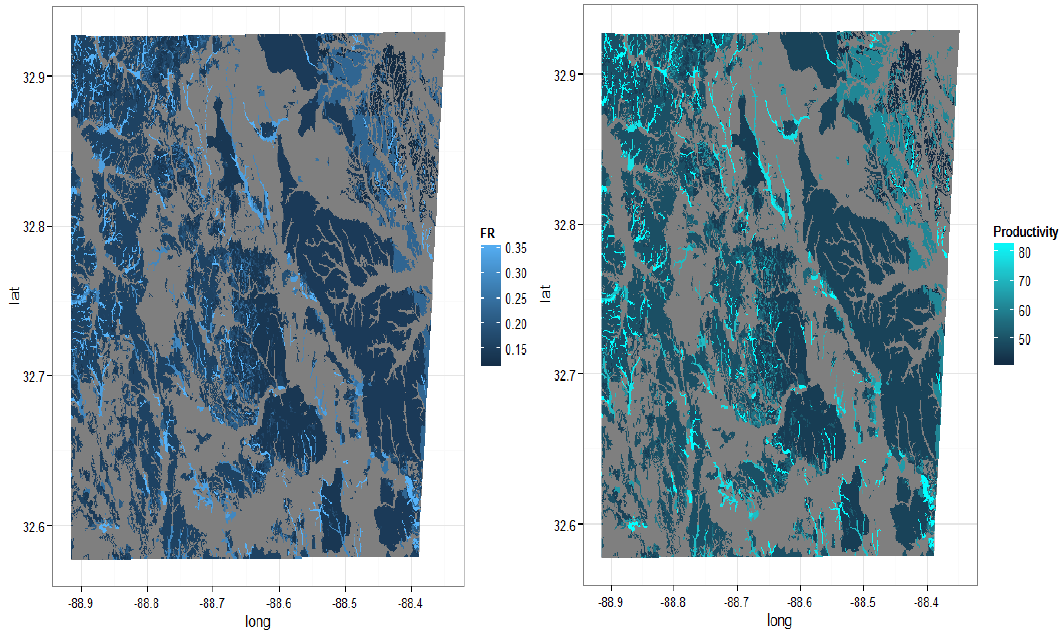
Figure 9. Map of 3-PG predicted aboveground biomass (Mg ha − 1 ) for 12-year-old loblolly pine in Kemper County, Mississippi. The top left diagram shows soil series mapped in Kemper County Mississippi based on SSURGO database. The top right diagram shows site index at base 25 calculated from SSURGO site index at base age 50 using the base age invariant method developed by [41]. The bottom left diagram shows FR values based on site index, and the bottom right diagram shows 3-PG predicted aboveground biomass based on FR values calculated from SSURGO site